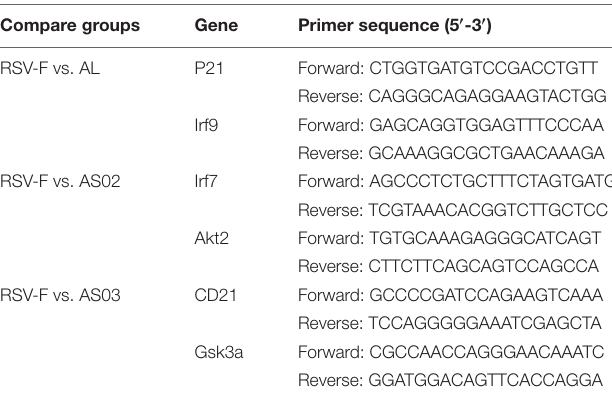
TABLE 1 | RT-qPCR